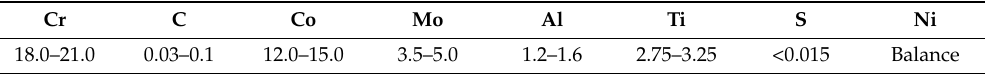
Table 1. Chemical composition of the GH4738 superalloy